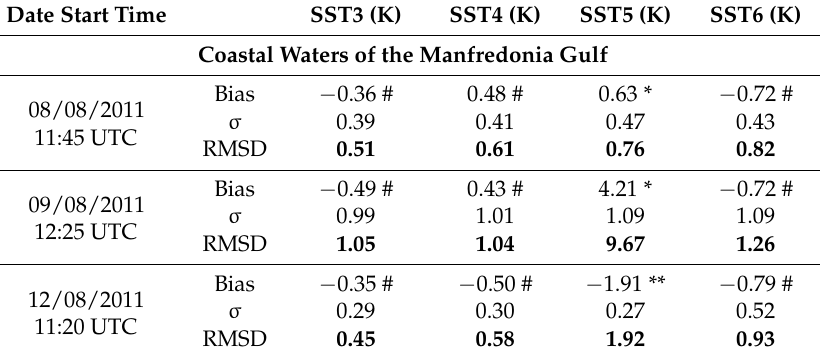
Table 3. Values of RMSD, bias, and σ between SST skin data and SST3, SST4, SST5, and SST6